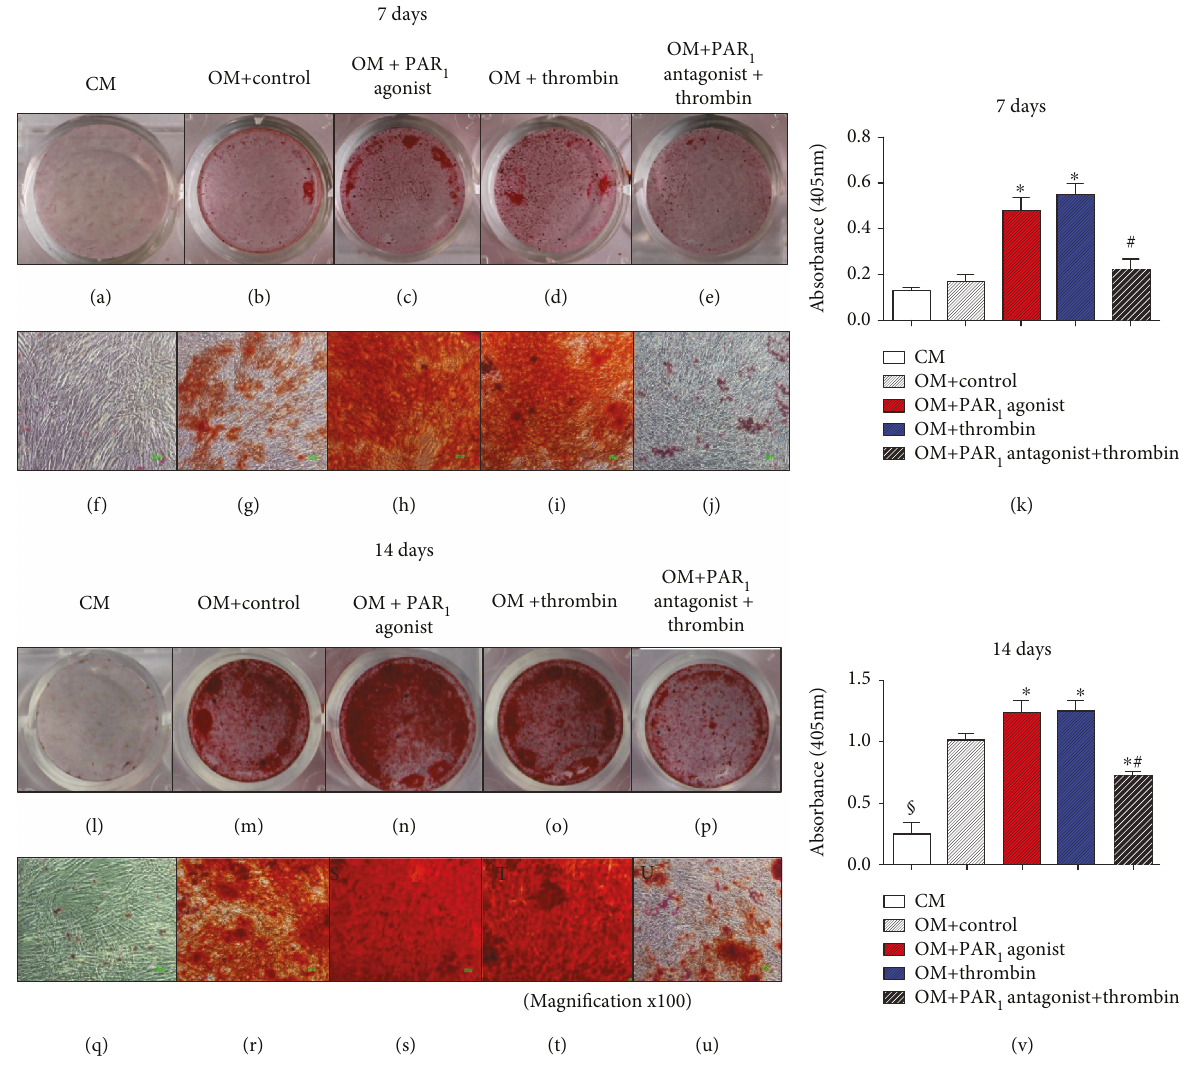
Figure 2: (a – j and l – u) E ff ects of PAR on mineral deposition using alizarin red staining after 7 and 14 days (a – e and l – p: zero magni fi cation; 1 f – j and q – u: magni fi cation × 100). (k, v) Quantitative alizarin red staining analysis after 7 and 14 days. Data are in mean and SD; n = 3 . ∗ Mean signi fi cant di ff erence when compared to OM + control ( p < 0 05 ). # Mean signi fi cant di ff erence when compared to OM + thrombin ( p < 0 05 ). § Mean signi fi cant di ff erence when compared to OM groups ( p < 0 05